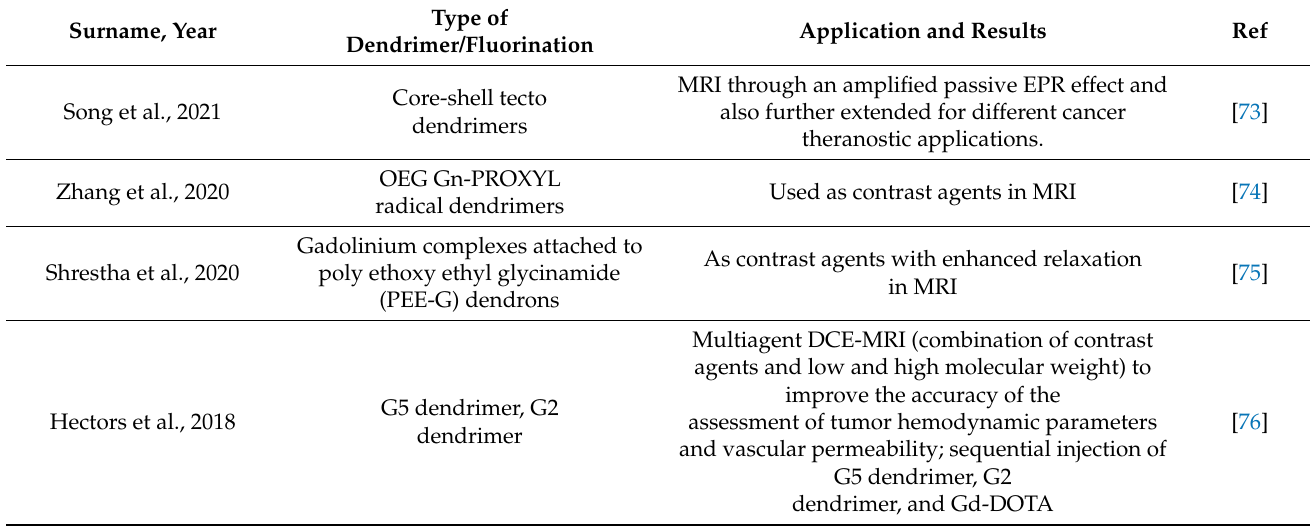
Table 2. Use of dendrimers as contrast agents in in vitro studies.